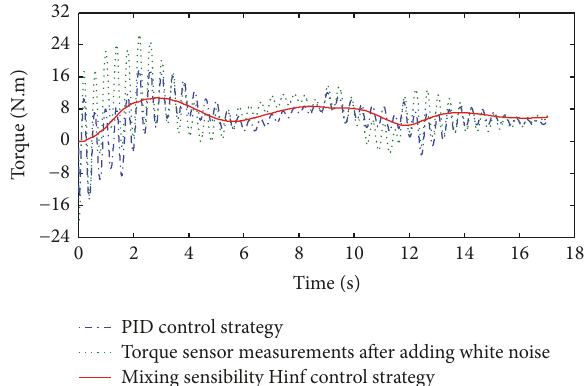
Figure 5: Comparison diagram of current tracking response.